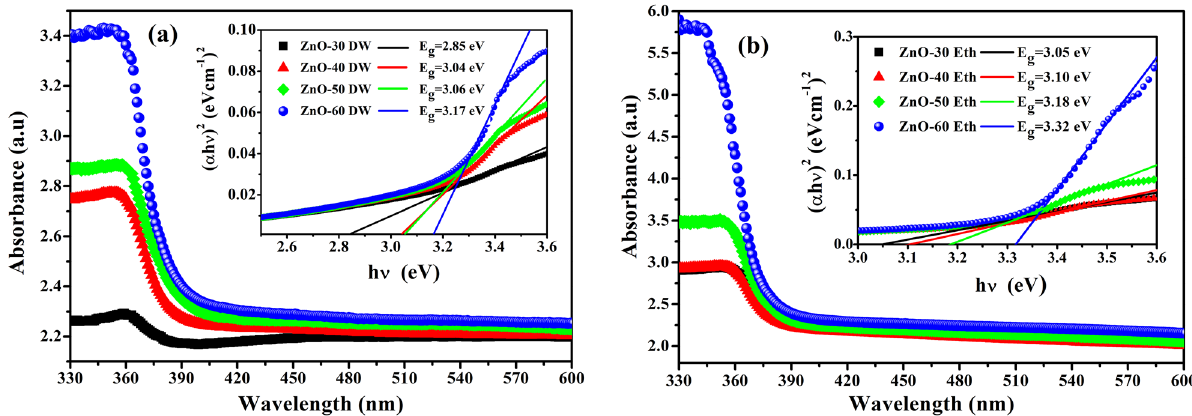
Figure 7. UV absorption and ( αhν ) 2 versus photon energy ( hν ) plots of ZnO films grown in ( a ) DW and ( b ) ethanol